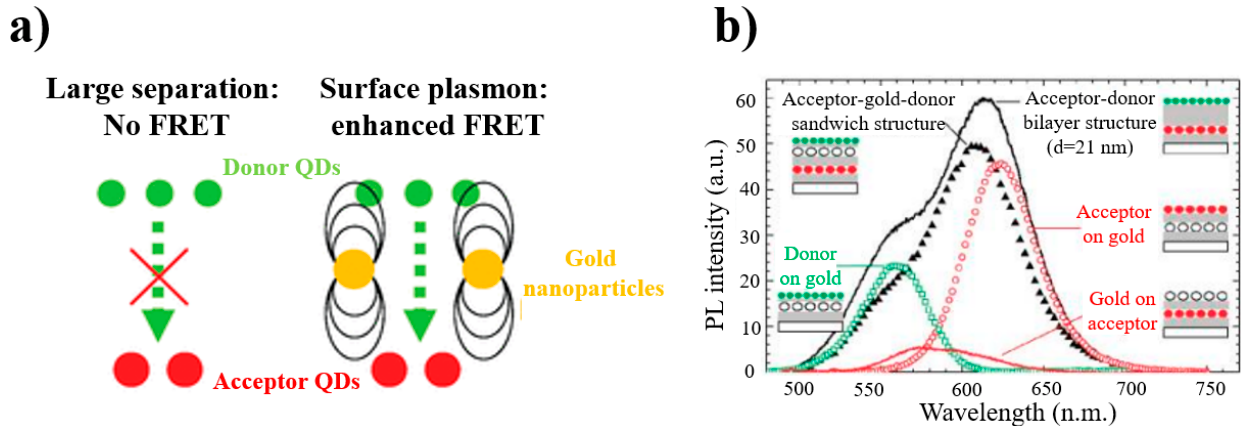
Figure 11. ( a ) Schematic diagram of energy transfer between CdTe regulated by surface plasmons of AuNPs. ( b ) Photoluminescence spectrum of this sandwich structure (black triangles) with different gold and QD con fi gurations. [74].